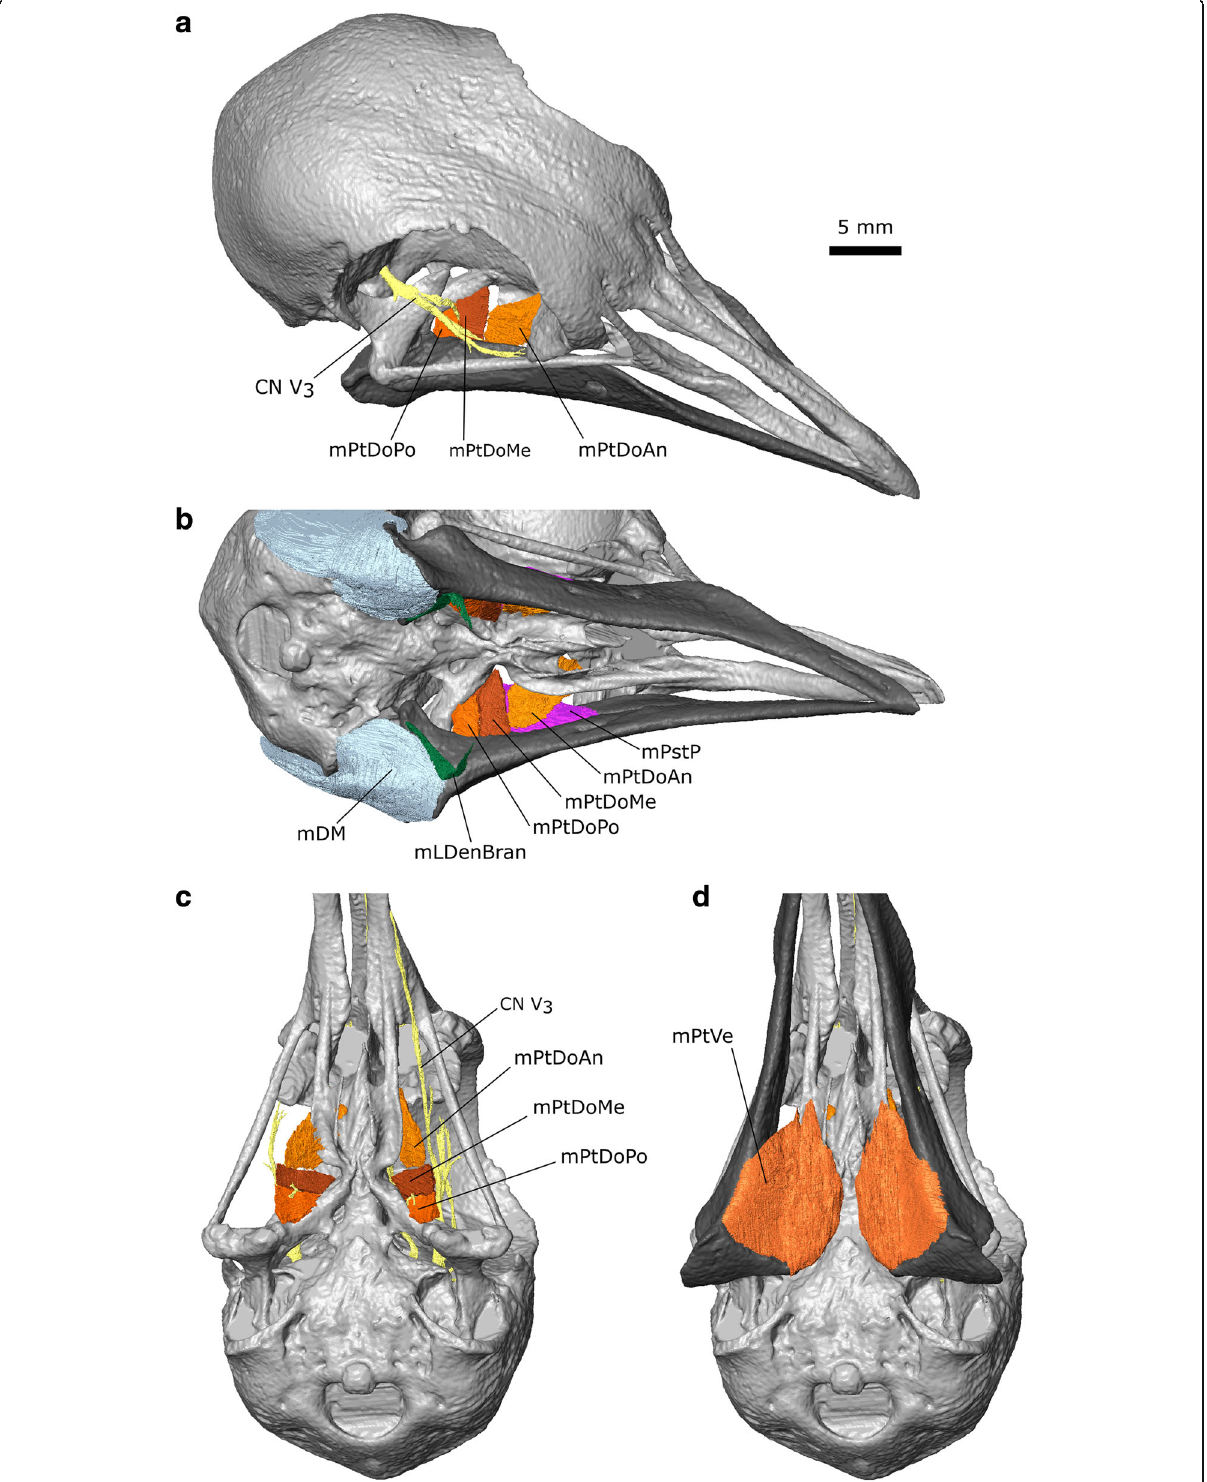
Fig. 10 The pterygoideus muscles of Columba livia . a dorsolateral view. b ventrolateral view without the mPtVe in place. c ventral view without the lower jaw and mPtVe. d ventral view with the lower jaw and